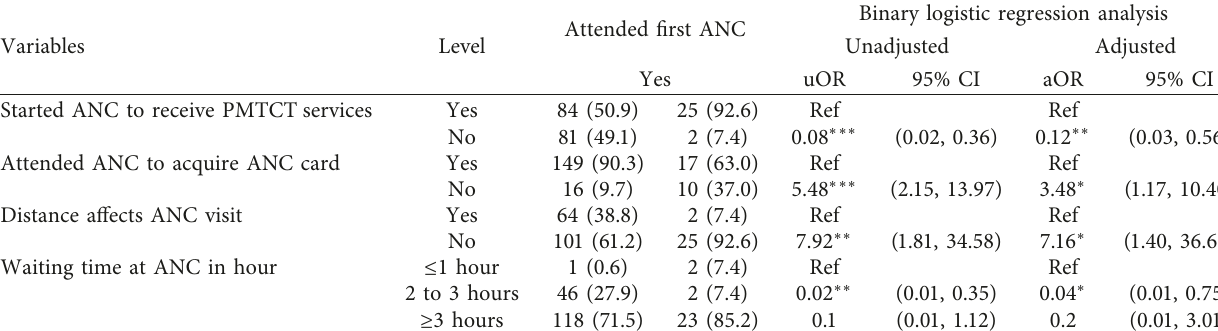
Table 5: Factors associated with first antenatal care in logistic regression analysis.